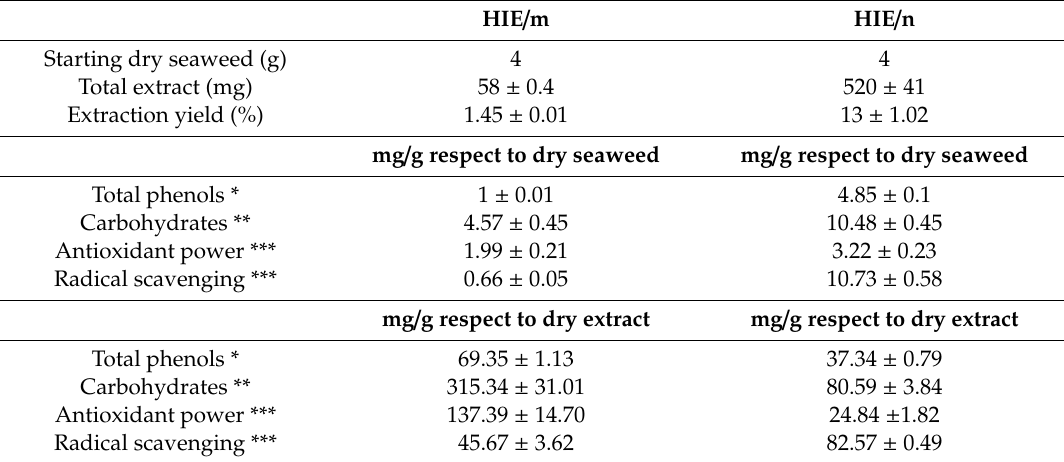
Table 1. Final yield of hydroalcoholic extraction and biochemical composition of H. incurva . Values are reported as mean ± standard deviations from at least three independent experiments from three di ff erent extractions.